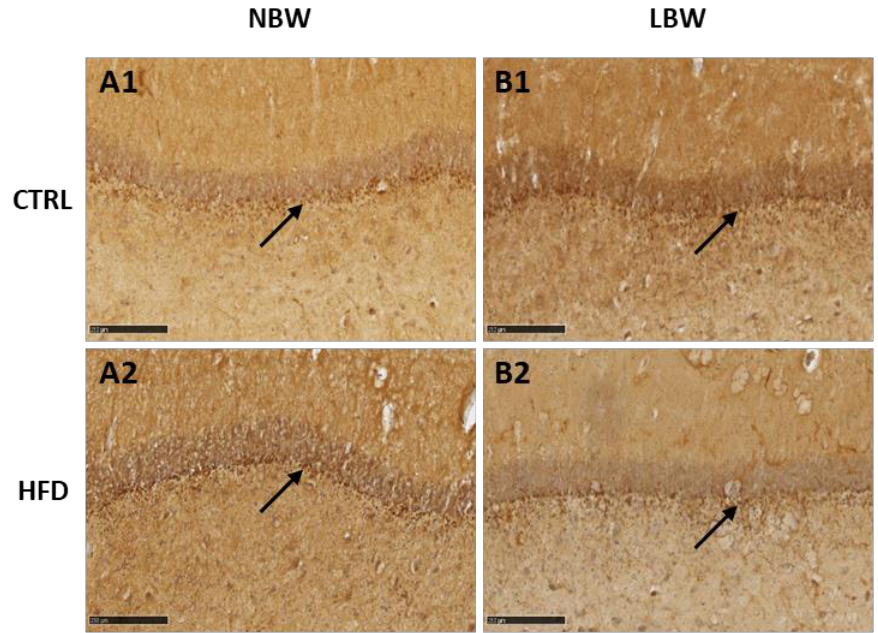
Figure 2. DCX immunostaining on the DG of the hippocampus of one year-old pigs born with normal birth weight (NBW, ( A )) or low birth weight as result of IUGR (LBW, ( B )) and fed a control diet (Ctrl) or an HFD diet (identified as 1 or 2, respectively). Representative images show the immature neurons immunostained with the DCX antibody. Scale bars: 250 µm.